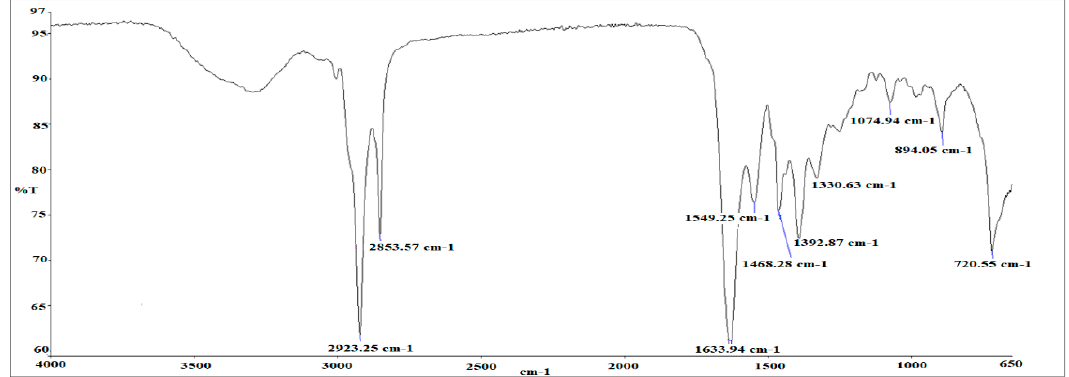
Figure 3. FTIR spectrum of as ‐ synthesized surfactant.